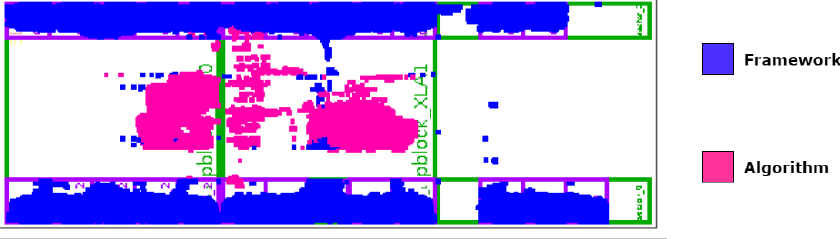
Figure 5. Calorimeter trigger algorithm floorplan for XCVU9P C2104 package FPGA. The trigger algorithms are placed in the middle of the SLR (magenta color). The firmware shell, which includes the MGTs firmware, is placed at the edges, which corresponds to the MGT ports (blue